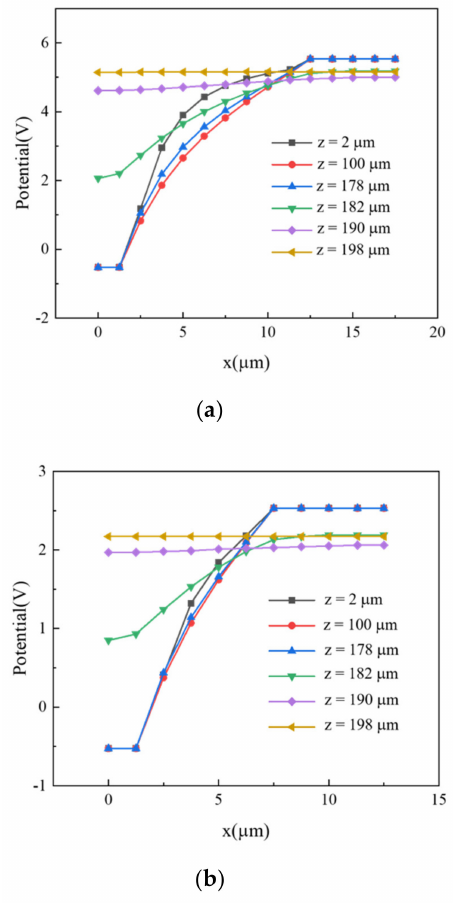
Figure 5. Electric potential curves for di ff erent detector structure thicknesses with electrode spacings of ( a ) 10 µ m and ( b ) 5 µ